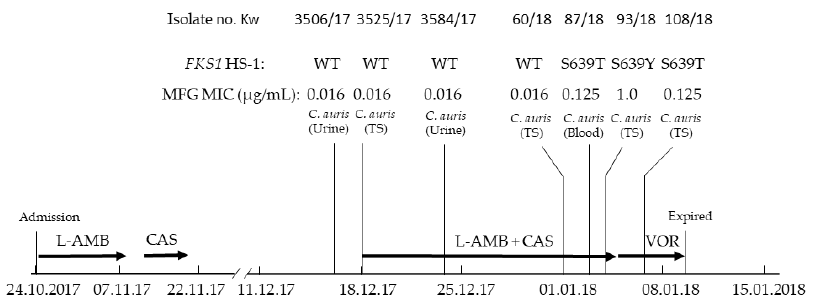
Figure 1. Time-line for the isolation of C. auris , antifungal treatment given to the patient and out- come. L-AMB, liposomal amphotericin B; CAS, caspofungin; MFG, micafungin; VOR, voriconazole; TS, tracheal secretion; FKS1 HS-1, hotspot-1 region of FKS1 gene; WT, wild-type. On Day 48, the patient became hemodynamically unstable and was started on 0.1